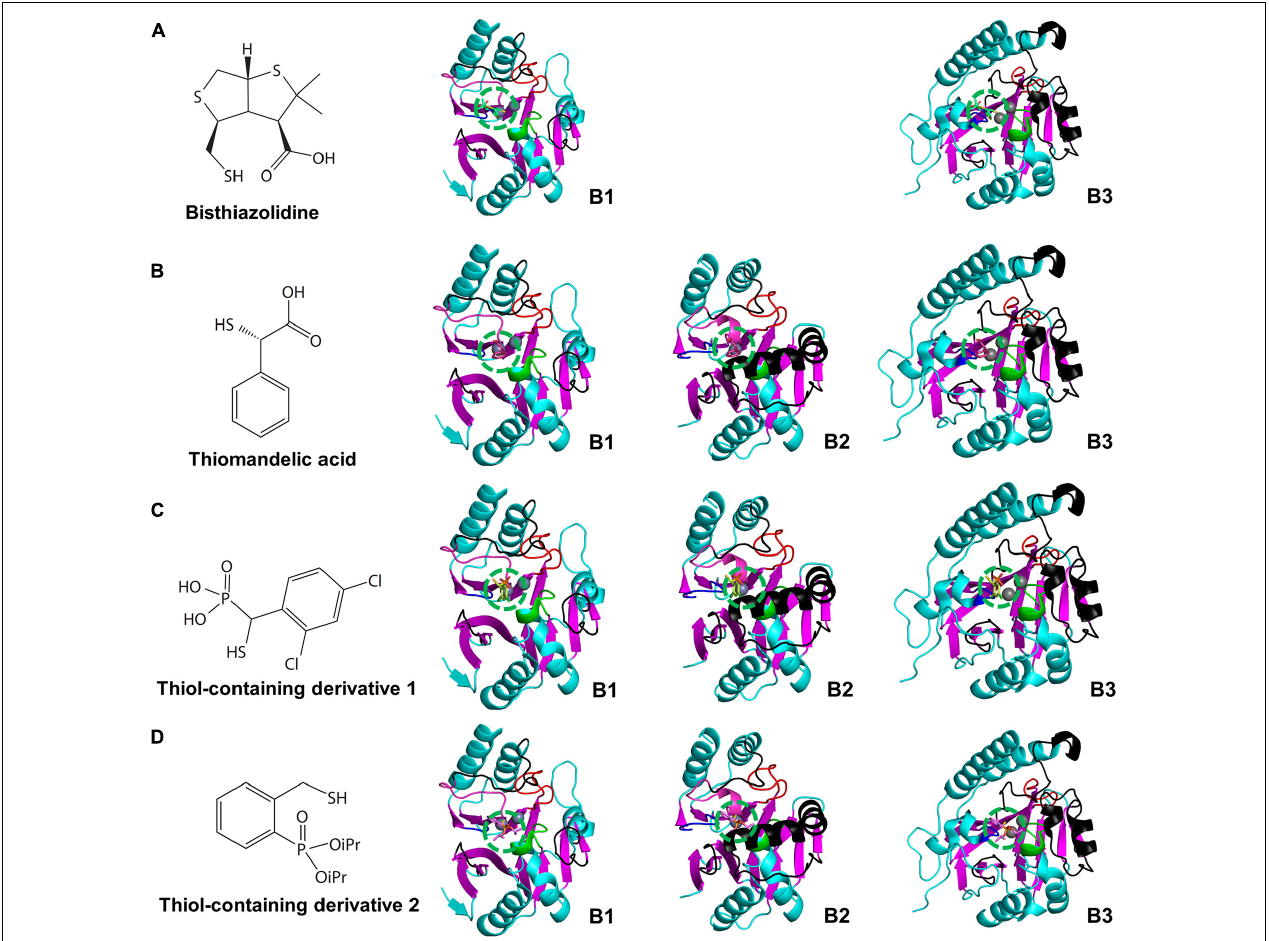
FIGURE 7 | The chemical structures of cross-class MBL inhibitors and their superimposed structures on the representative B1, B2, and B3 MBLs. The chemical structures of (A) bisthiazolidine, (B) thiomandelic acid, (C,D) thiol-containing derivatives and their superimposed structures on the B1, B2, and B3 MBLs of NDM-1, CphA, and AIM-1, respectively. The binding sites of the cross-class inhibitors are represented by green dashed circles. The binding sites are well conserved on top of the zinc-binding site(s). The superimposed cross-class MBL inhibitors with small globular shapes show limited steric hindrances with the substrate-binding pockets of the B1, B2, and B3 MBLs. In (D), iPR represents isopropyl